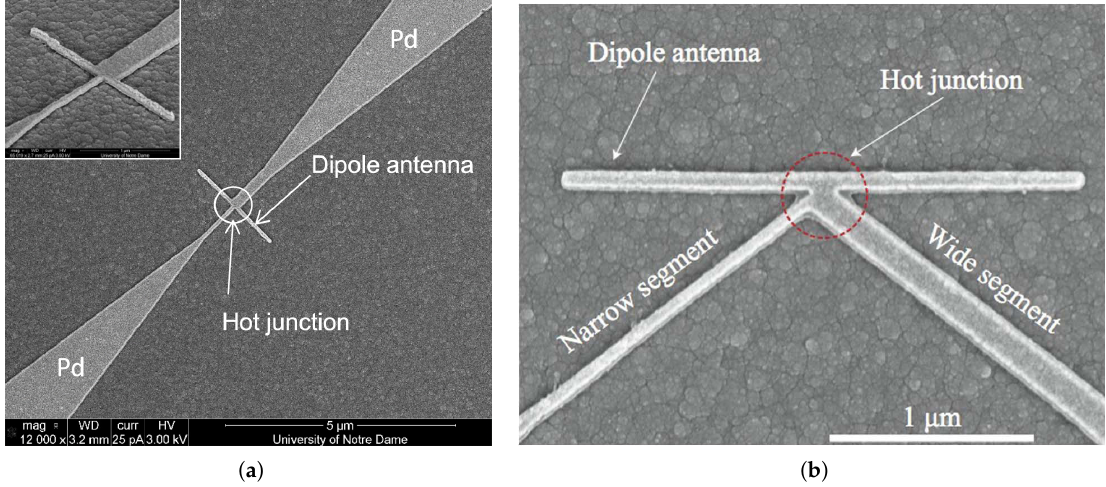
Figure 18. Examples of single metal antenna coupled nano-thermocouple